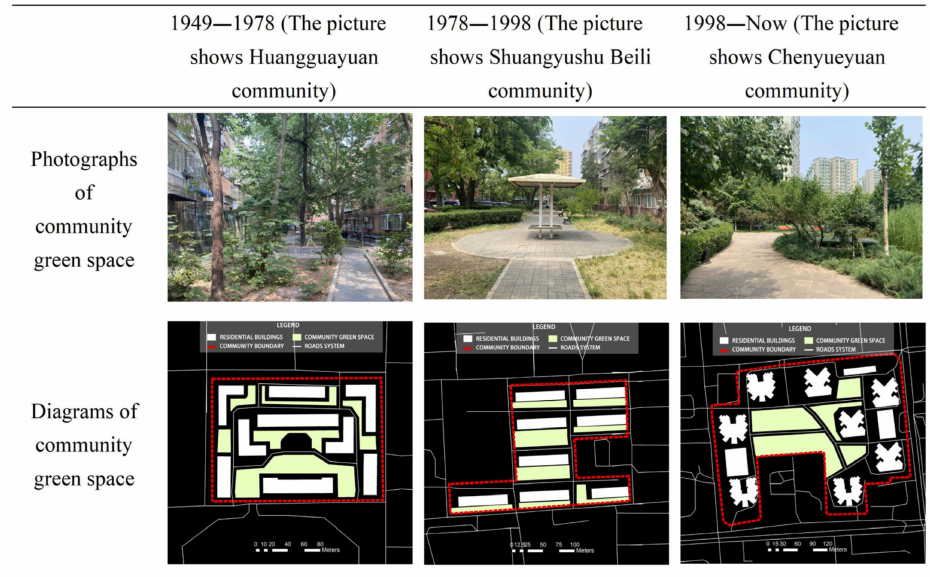
Figure 1. Diagrams and photographs of typical community green space in each time